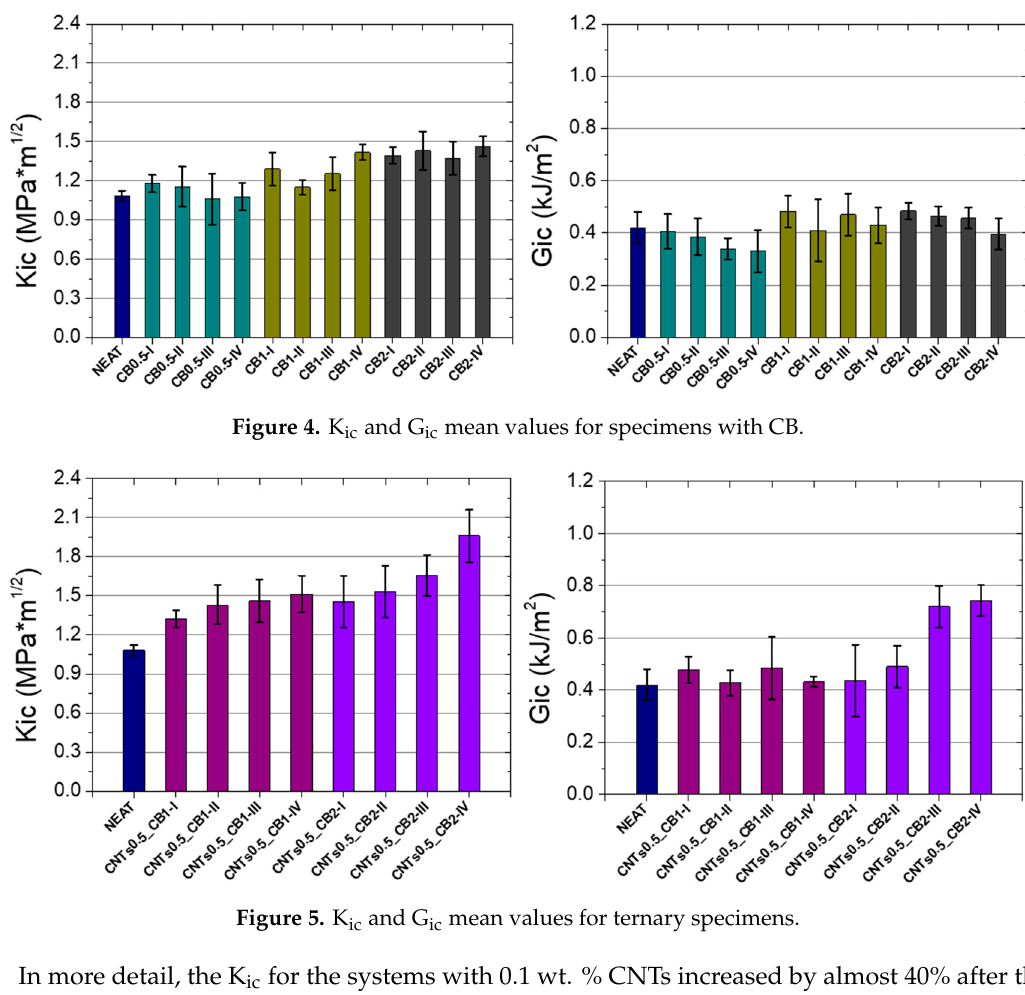
Figure 3. K ic and G ic mean values for specimens with CNTs.